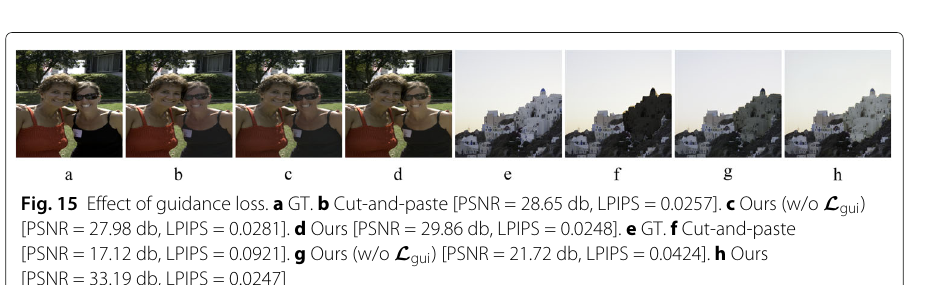
Fig. 15 Effect of guidance loss. a GT. b Cut-and-paste [PSNR = 28.65 db, LPIPS = 0.0257]. c Ours (w/o L gui ) [PSNR = 27.98 db, LPIPS = 0.0281]. d Ours [PSNR = 29.86 db, LPIPS = 0.0248]. e GT. f Cut-and-paste [PSNR = 17.12 db, LPIPS = 0.0921]. g Ours (w/o L gui ) [PSNR = 21.72 db, LPIPS = 0.0424]. h Ours [PSNR = 33.19 db, LPIPS = 0.0247]